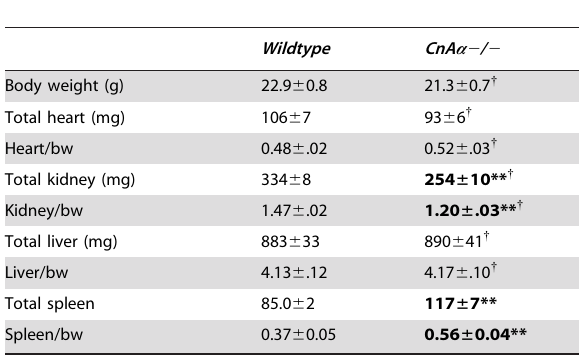
Table 1. Organ weights in WT and rescued CnA a 2 / 2